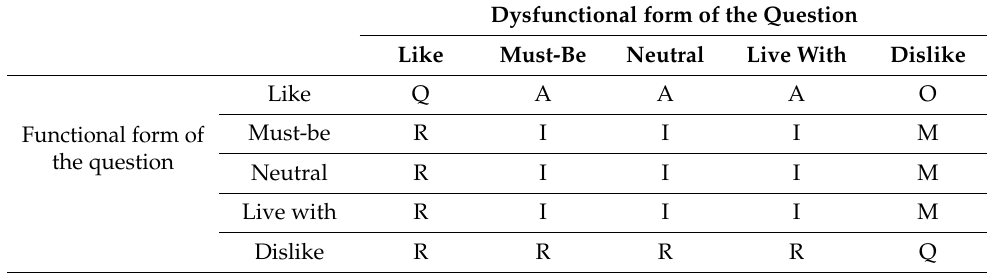
Table 2. Kano model evaluation